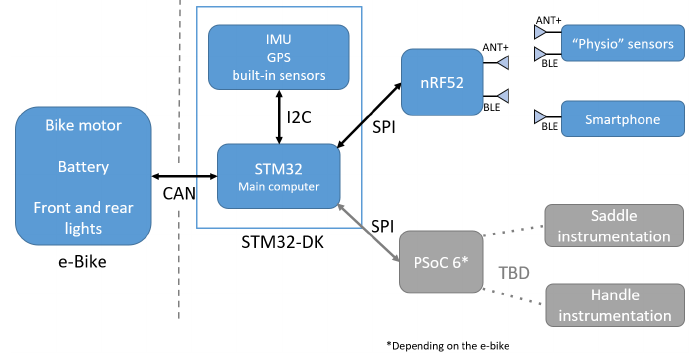
Figure 2. Embedded system overview.